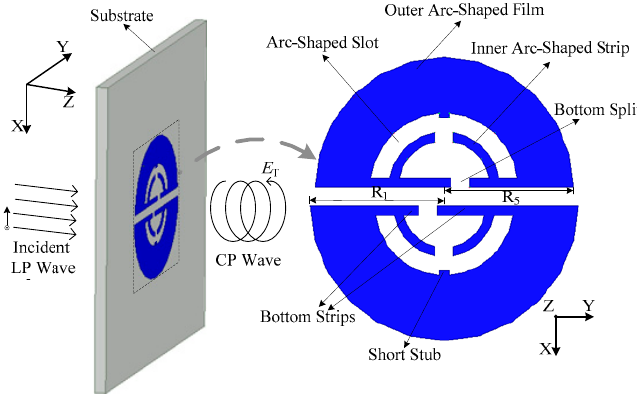
Figure 2. Configuration of the proposed circular polarizer.